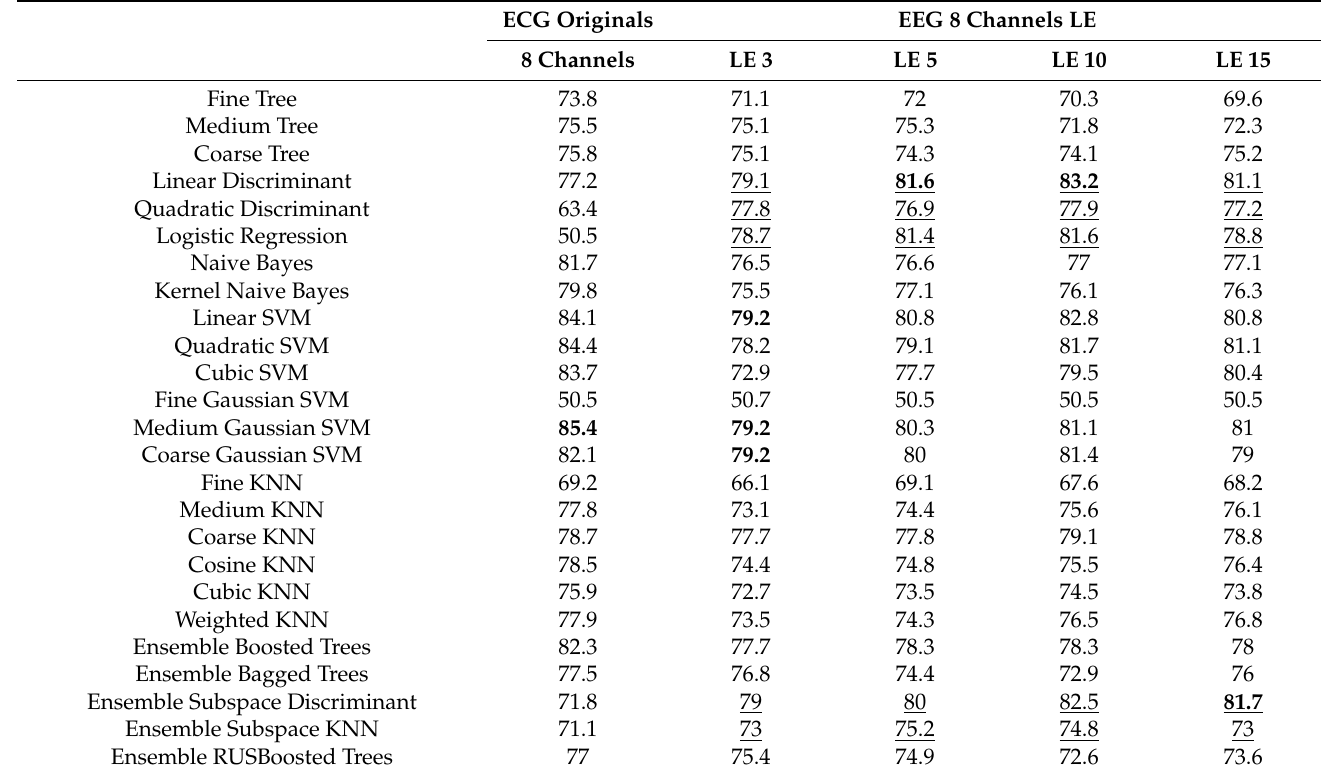
Figure 12. Results for the dimensionality reduction with LE algorithm for configurations with 8 channels. Table 6. Classification results with LE algorithm for configurations with 8 channels.